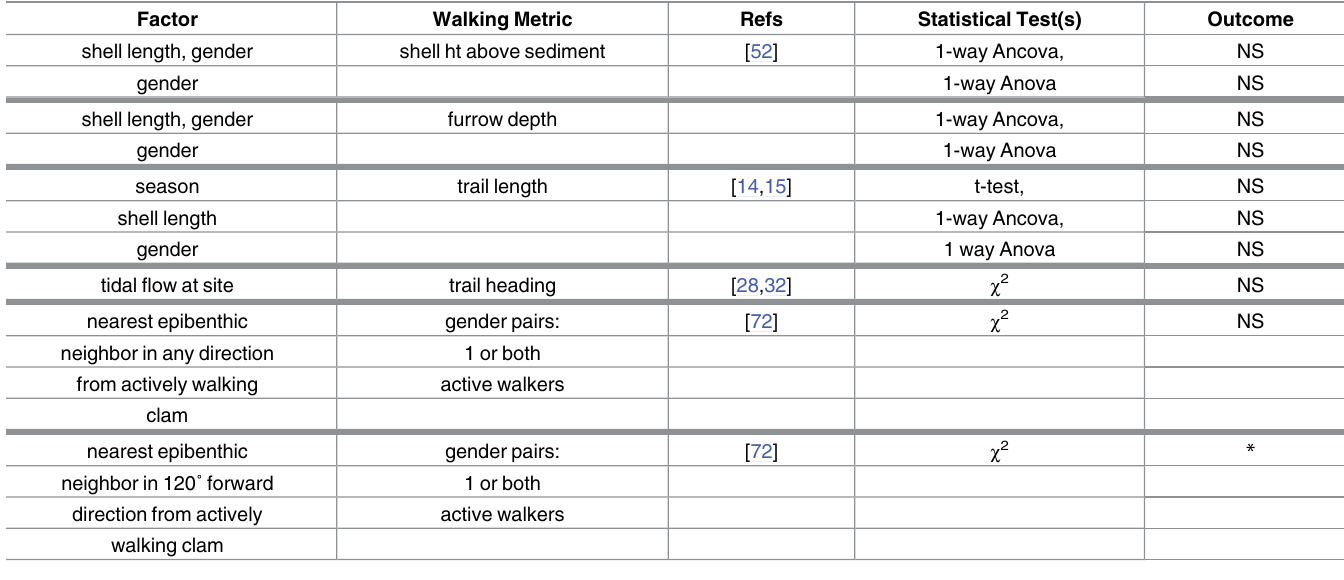
Table 2. Summaryof factors hypothesized to affect specific metricsof observed hard clam walking behavior in the Peconic Bays, New York, USA. Factor Walking Metric